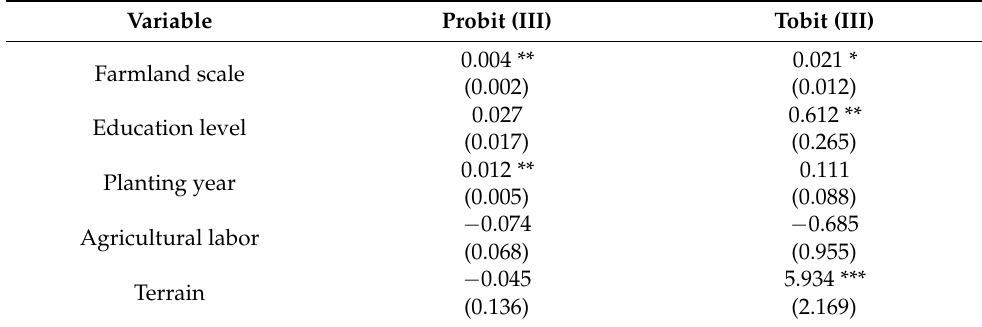
Table 5. The results of the robustness